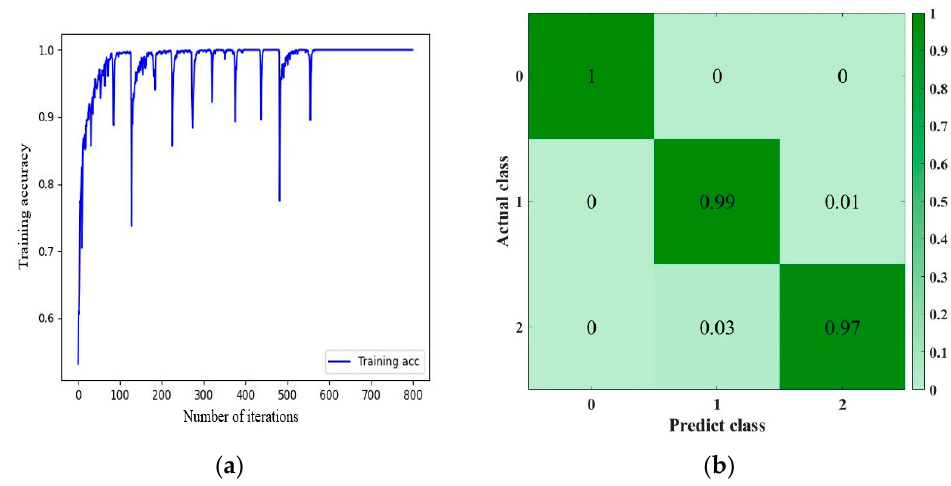
Figure 9. The learning curve and confusion matrix of the SE-MCNN model. ( a ) Training curve. ( b ) Test set confusion matrix.